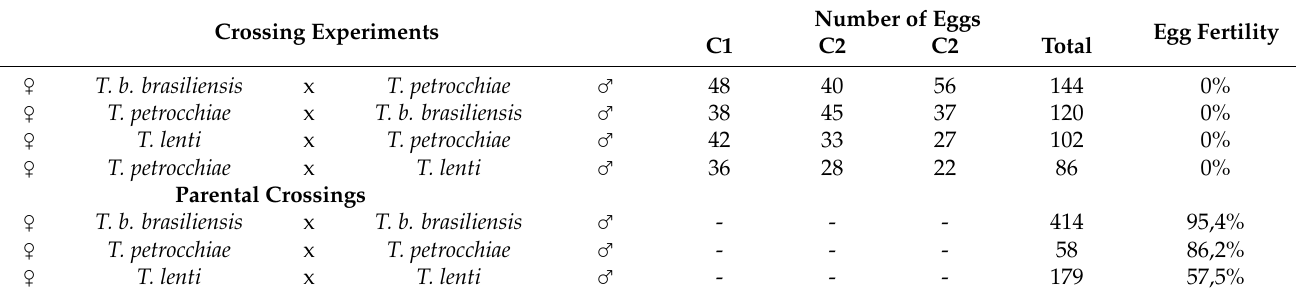
Table 1. Experimental crosses performed between T. petrocchiae x T. b. brasiliensis and T. lenti . Crossing Experiments